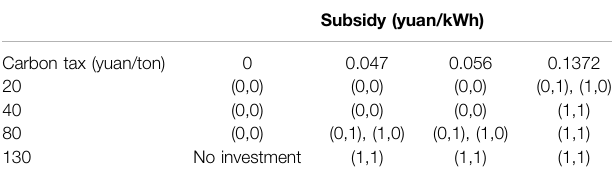
TABLE 4 | Simulation results in the carbon tax